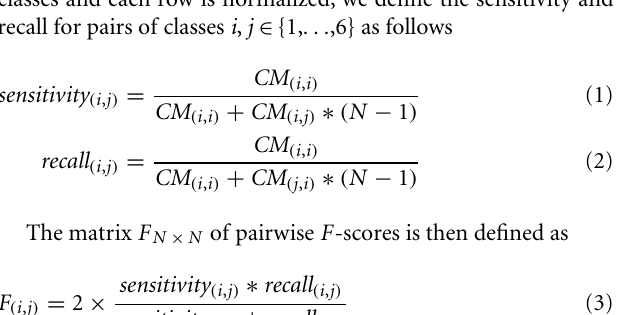
FIGURE 2 |Visualization of iteration-specific decision threshold. The confidence measure p is plotted for correct ( P + ) and incorrect ( P − ) decisions as a function of the number of iterations j .The black line F is fitted to the maximum values of P − .The decision threshold T is defined as the maximum of F and the median of P +